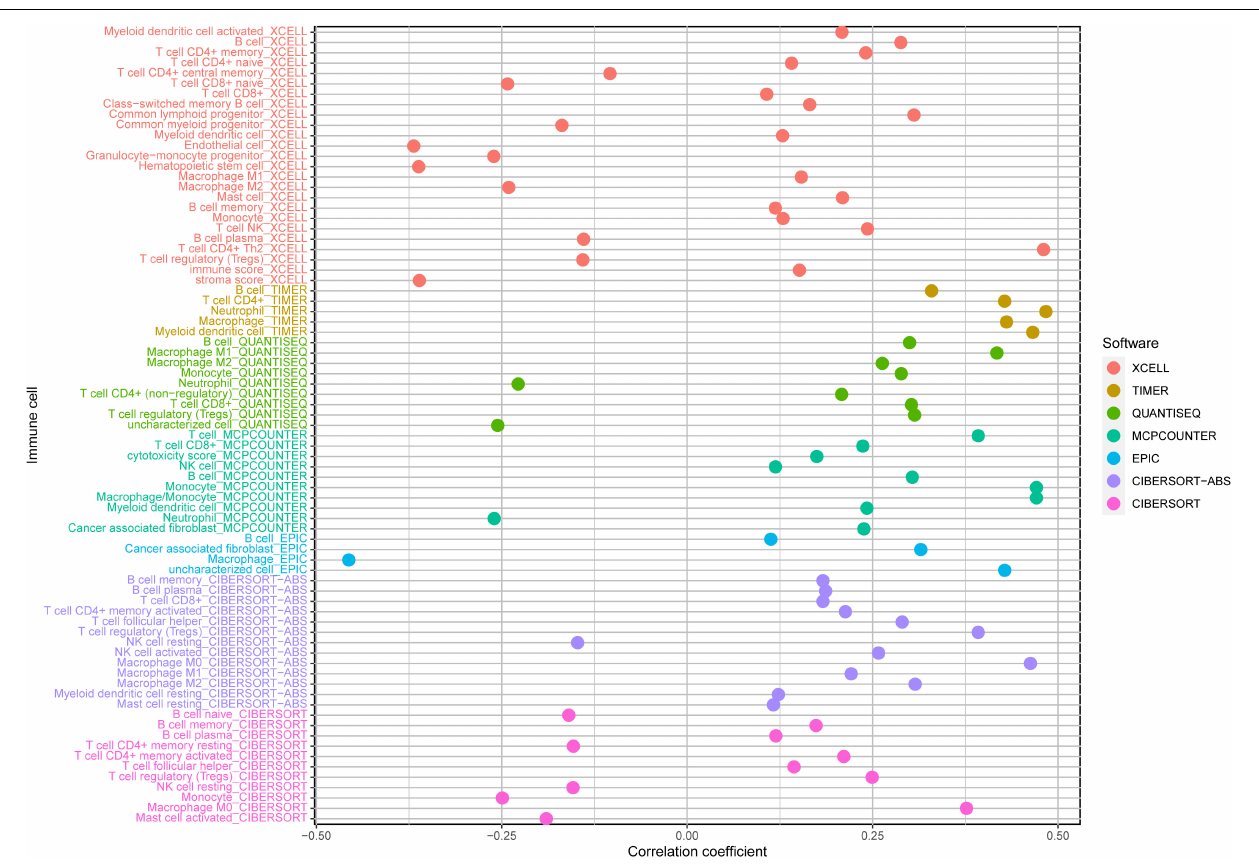
FIGURE 10 | A detailed Spearman correlation analysis was also performed using different algorithms; a lollipop shape to exhibited the result, and from the results, we can find that most immune cells have a positive correlation with the risk score. TIMER, tumor immune estimation resource.